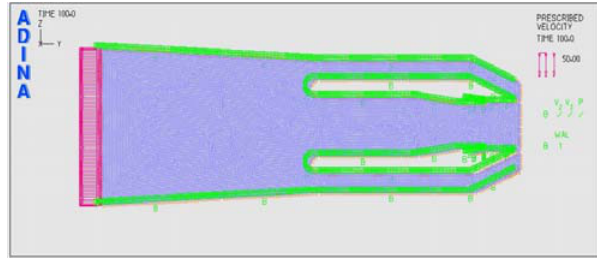
Fig 6. Defining of starting and boundary